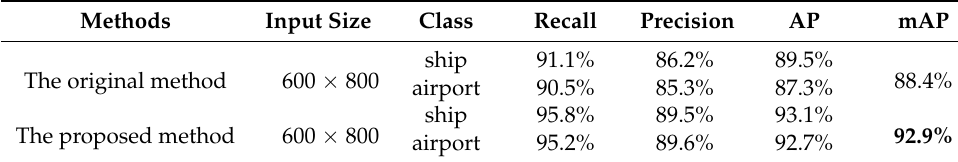
Figure 10. Effect of scale transfer layer. ( a ) is the initial image. ( b ) is the image with the truth box. ( c ) is the detection image without the scale transfer layer method. ( d ) is the detection image using the scale transfer layer method. As shown in the figure, ( e , f ) are simple scenes, and ( g , h ) are complex scenes. Table 2. Feasibility of scale transfer